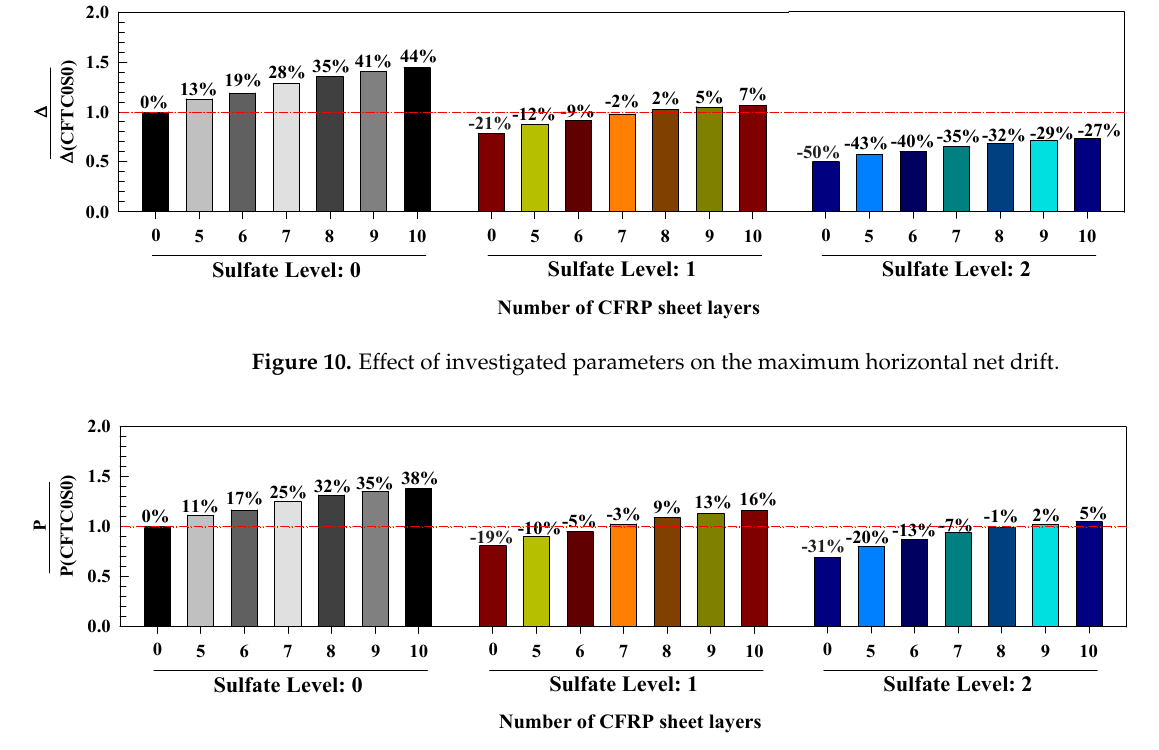
Figure 11. Effect of the investigated parameters on the horizontal load capacity.